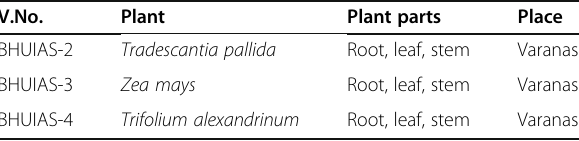
Table 1 Plant taken during the study for the isolation of endophytic fungi